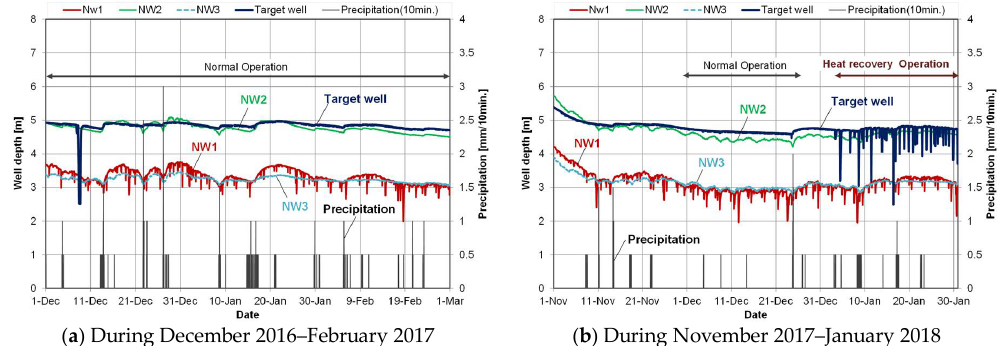
Figure 5. Well-water depth changes along with the neighborhood well.